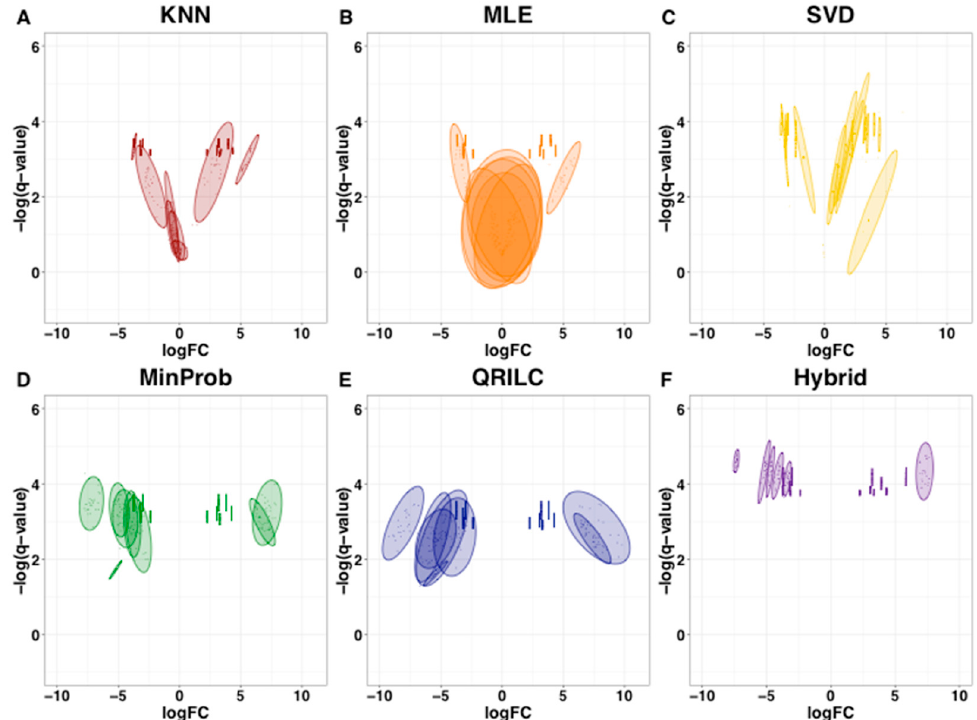
Figure 4. ( A – F ) Spread plots of − log q -value vs. logFC for merged top proteins across all imputation methods for MDA-MD-468 data. Following 25 consecutive iterations, each dataset from each imputation method was ranked by q -value mean. The top 10 proteins from each method were pooled into a top protein list (Supplemental Table S2) and plotted here. The ellipse represents a 95% confidence interval. Note MinDet is not shown as this method imputes the same value after each iteration.